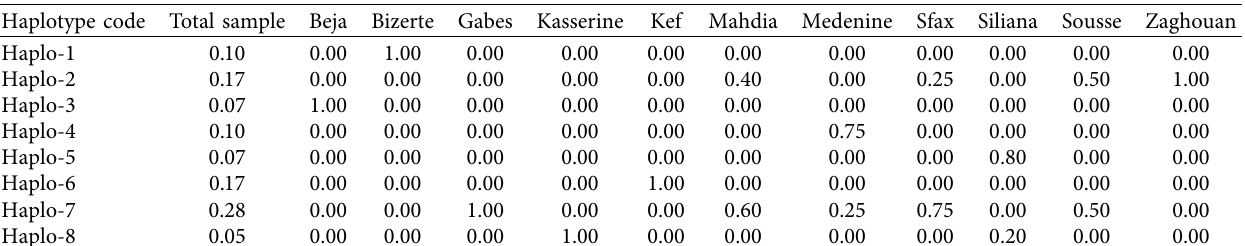
Table 3: Distribution and frequencies of the detected chloroplast haplotypes among the investigated populations of barley landraces. Haplotype code Total sample Beja Bizerte Gabes Kasserine